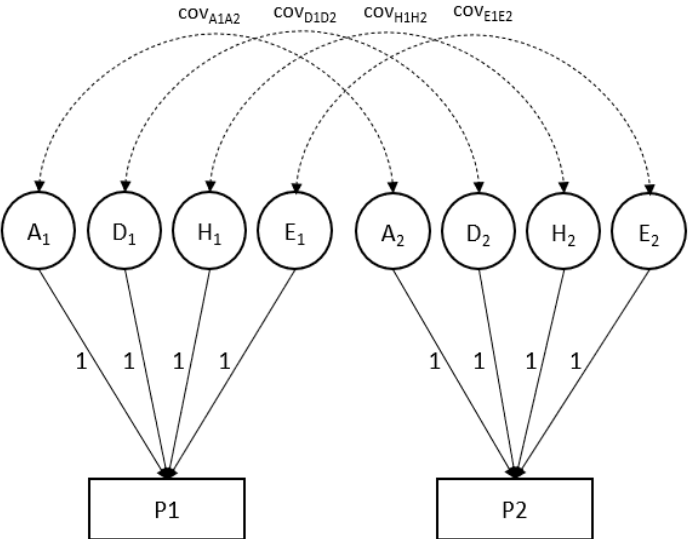
Figure 1. Illustration of a bivariate model, where the variance of each phenotype (P1 and P2) is due to four factors (A, D, H, E), and the covariance (cov) reflects the variance that is shared between the A, D, H and E factors. We estimated the variance of the latent factors and the covariances indicated in the figure.